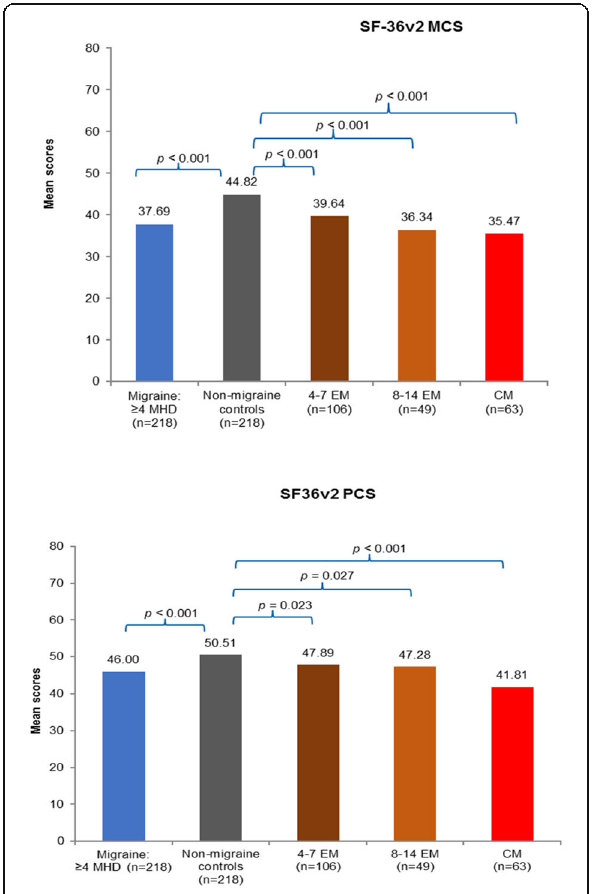
Fig. 2 MCS and PCS scores of SF-36v2 of migraine subgroups vs propensity score matched non-migraine controlsT-tests were used for analysis.CM, chronic migraine; EM, episodic migraine; MCS, mental component summary; MHD, monthly headache day; PCS, physical component summary.